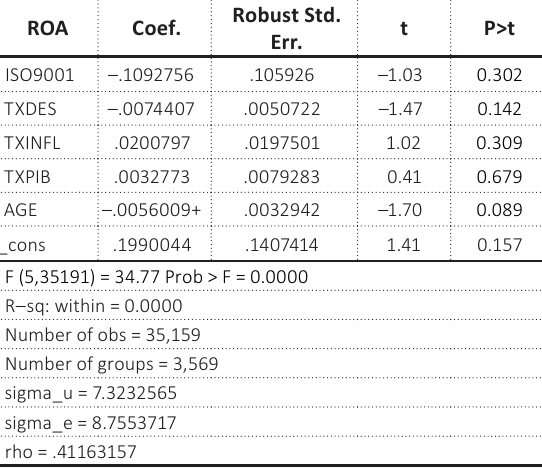
Table 5. Results of the ISO9001 regression